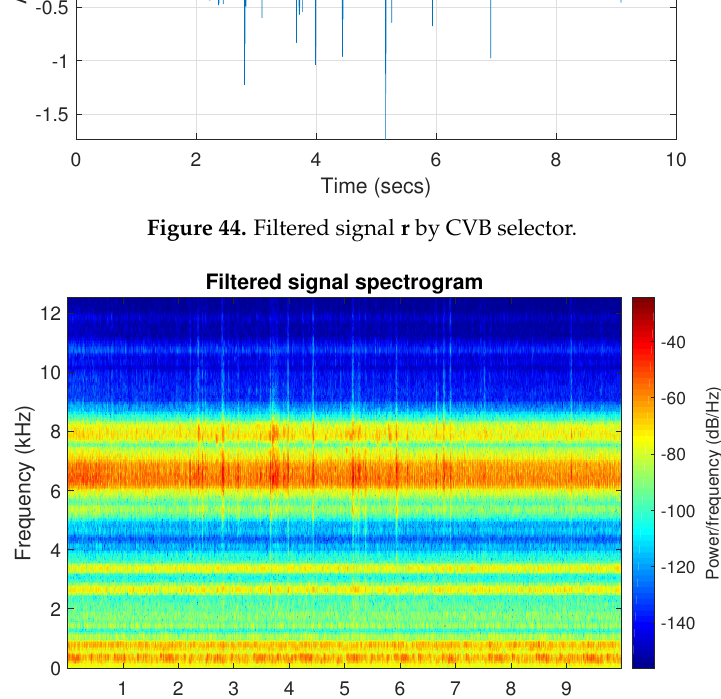
Figure 45. Spectrogram of filtered signal r by CVB selector.